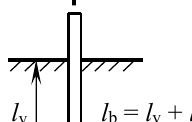
Figure 12. Schematic of bent rebar.